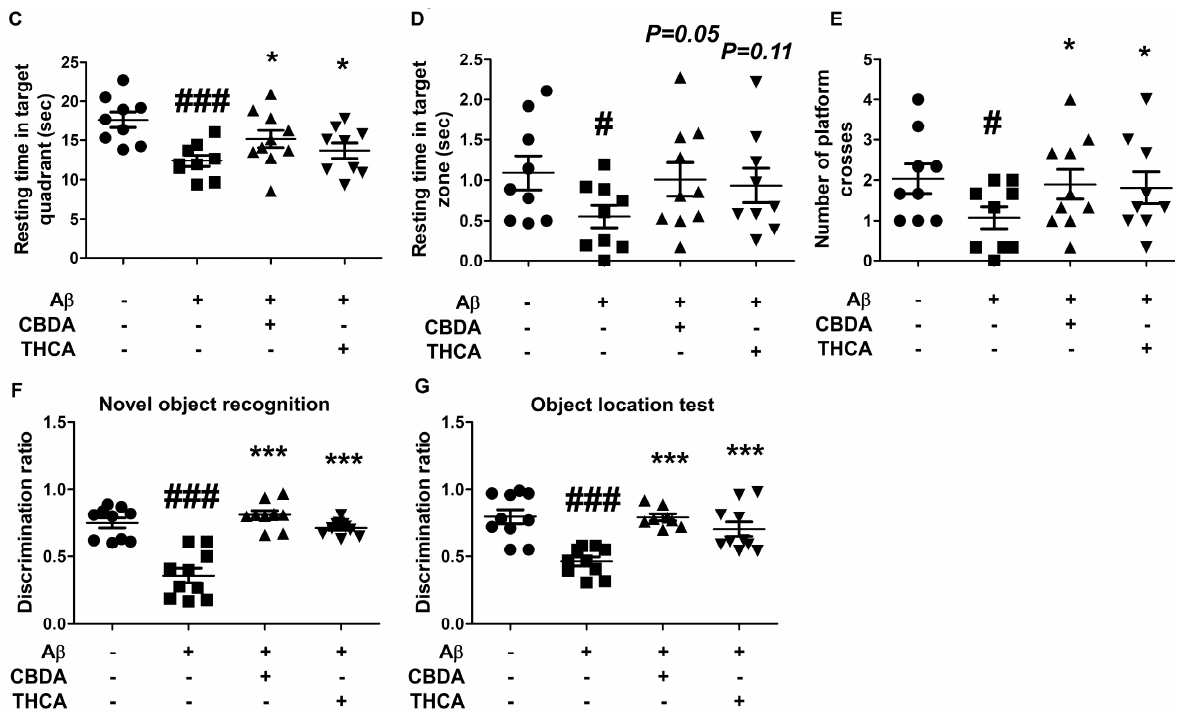
Figure 3. Effects of CBDA and THCA on learning and memory in A β 1–42 -treated mice. ( A ) Schedule used for the behavioral tests. ( B ) Mean escape latency results for the Morris water maze test (mean ± SEM, two-way repeated measures ANOVA, followed by Bonferroni’s post-hoc test; n = 10 per group). Time spent in ( C ) target quadrant area and ( D ) platform area. ( E ) Number of crosses in the platform area. ( F ) Discrimination ratio results for the novel object recognition test. ( G ) Discrimina- tion ratio results for the object location test. (mean ± SEM, # p < 0.05 and ### p < 0.001 vs. PBS-treated, * p < 0.05 and *** p < 0.001 vs. A β 1-42 -treated, one-way ANOVA followed by Fisher’s LSD; n = 10 per group).